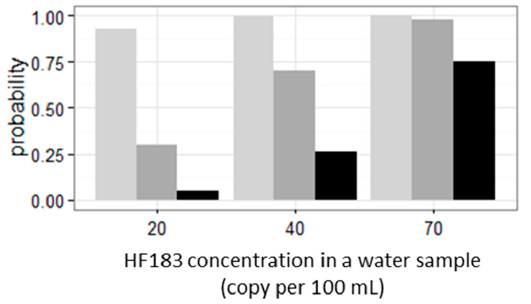
Figure A4. Probability of HF183 amplifying in at least one (light grey), at least two (dark grey) or all three (black) qPCR replicates at low HF183 concentration ( x -axis). This simulation only accounts for subsampling effects as 2 µ L of the 100 µ L total DNA extract from the water sample are analyzed in each qPCR reaction, while assuming 100% recovery during DNA extraction and perfect qPCR kinetics (i.e., 100% amplification for all reactions having at least one copy of the target present). Such an assumption is untrue [39], and the real probability of amplification is lower than shown here.